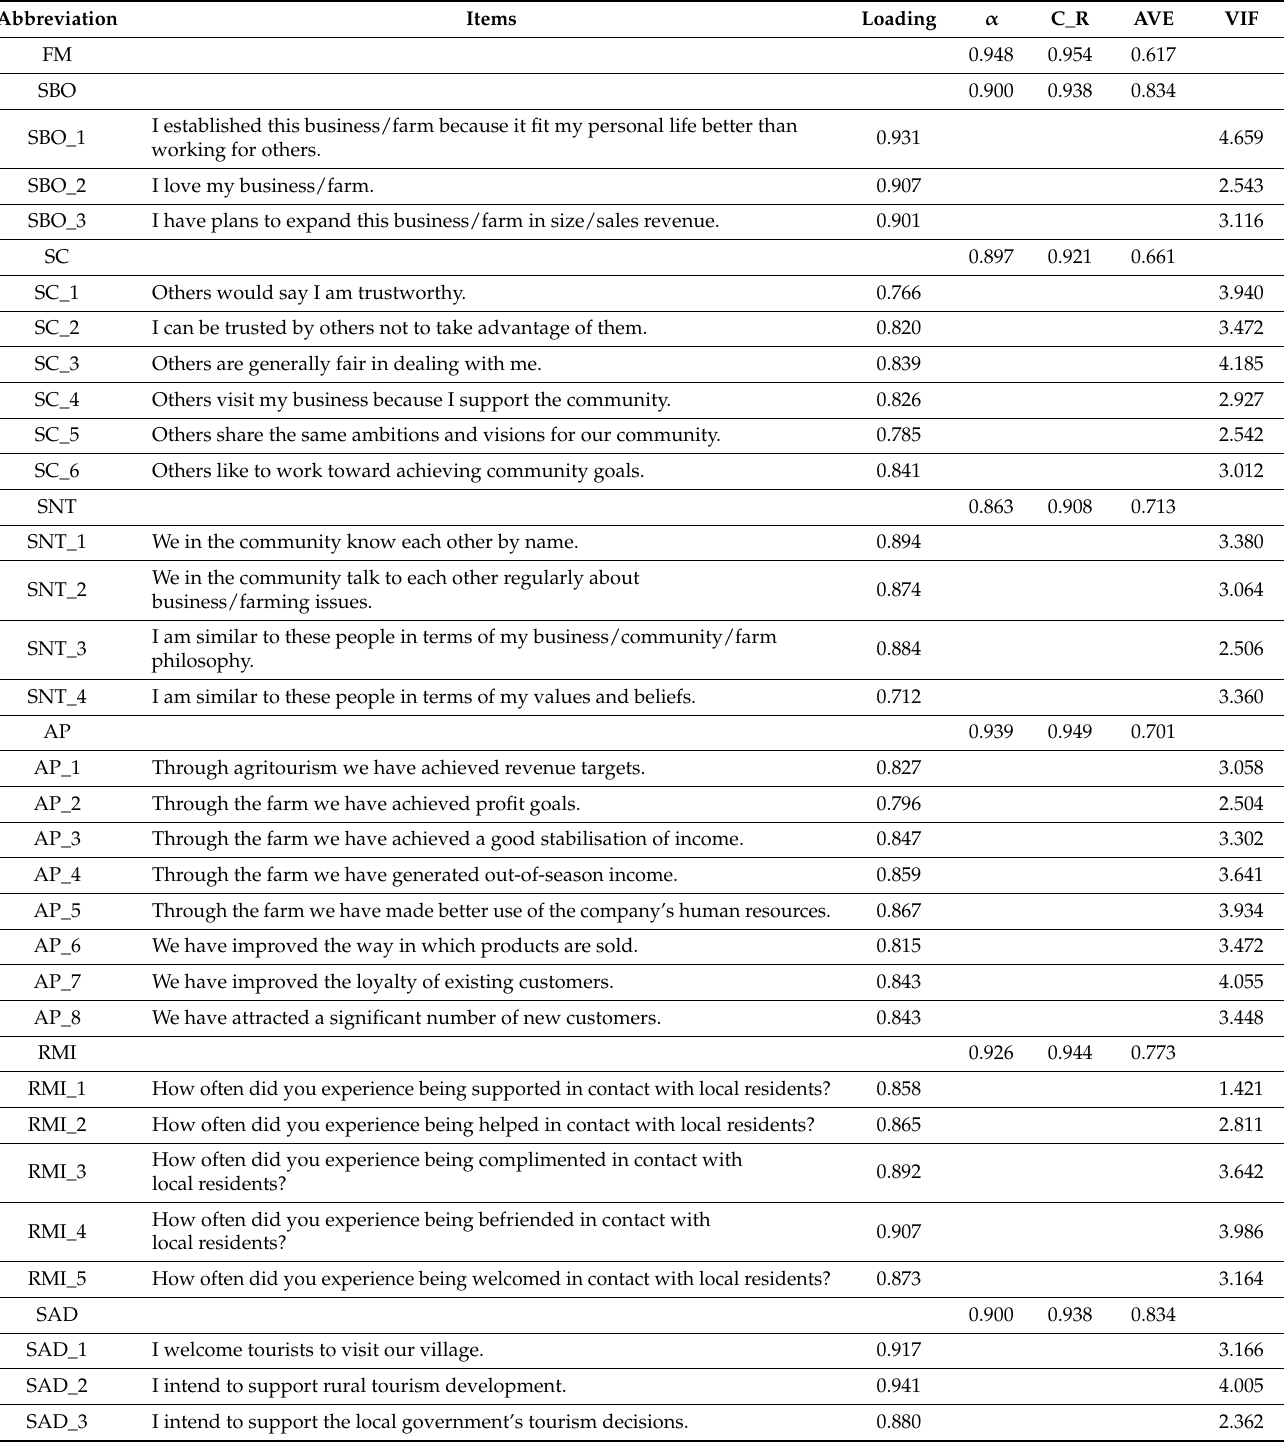
Table 1. Assessment of the outer model